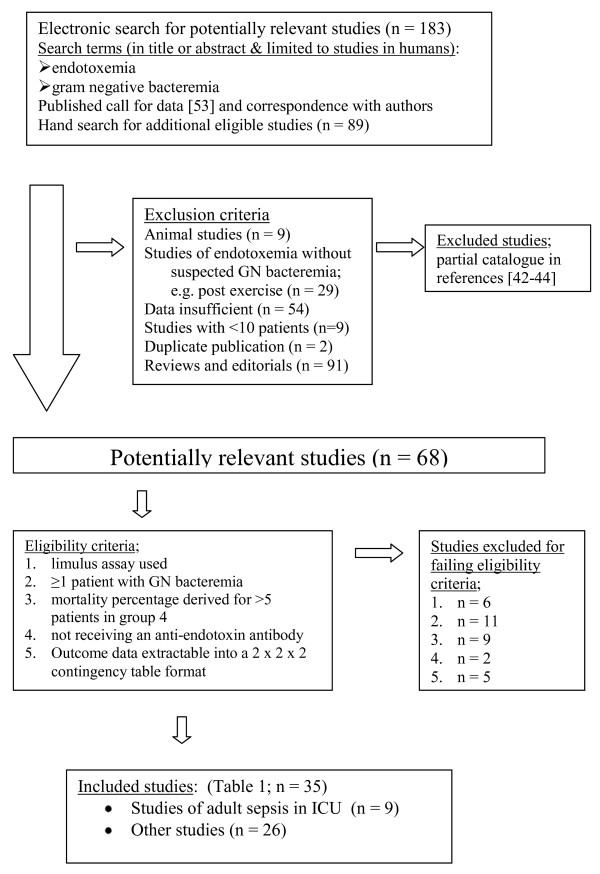
Flow diagram of study selection within the meta-analysis.